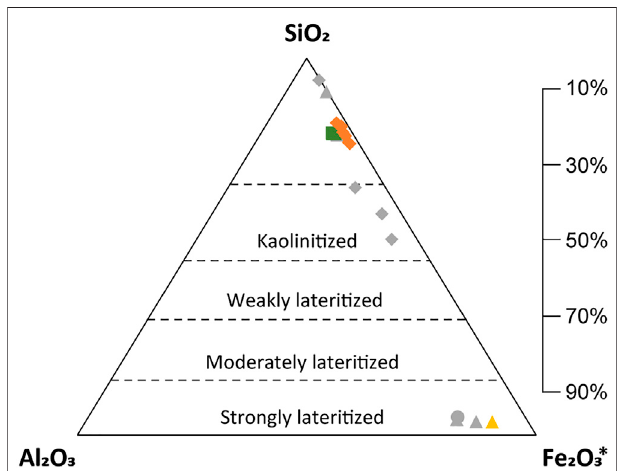
FIGURE 9 | Ternary diagram of SiO 2 -Al 2 O 3 - Fe 2 O 3 * for the laterite horizon in the Morowali deposit and its index of lateritization (IOL). IOL representsthe degree ofweathering inthe quantitativecalculationofchemical composition. The calculation formula of IOL is as follows: IOL (cid:1) 100x((Al 2 O 3 +Fe 2 O 3 *)/(SiO 2 +Al 2 O 3 +Fe 2 O 3 *)) (Tupaz et al., 2020). Legend is same as in Figure 8